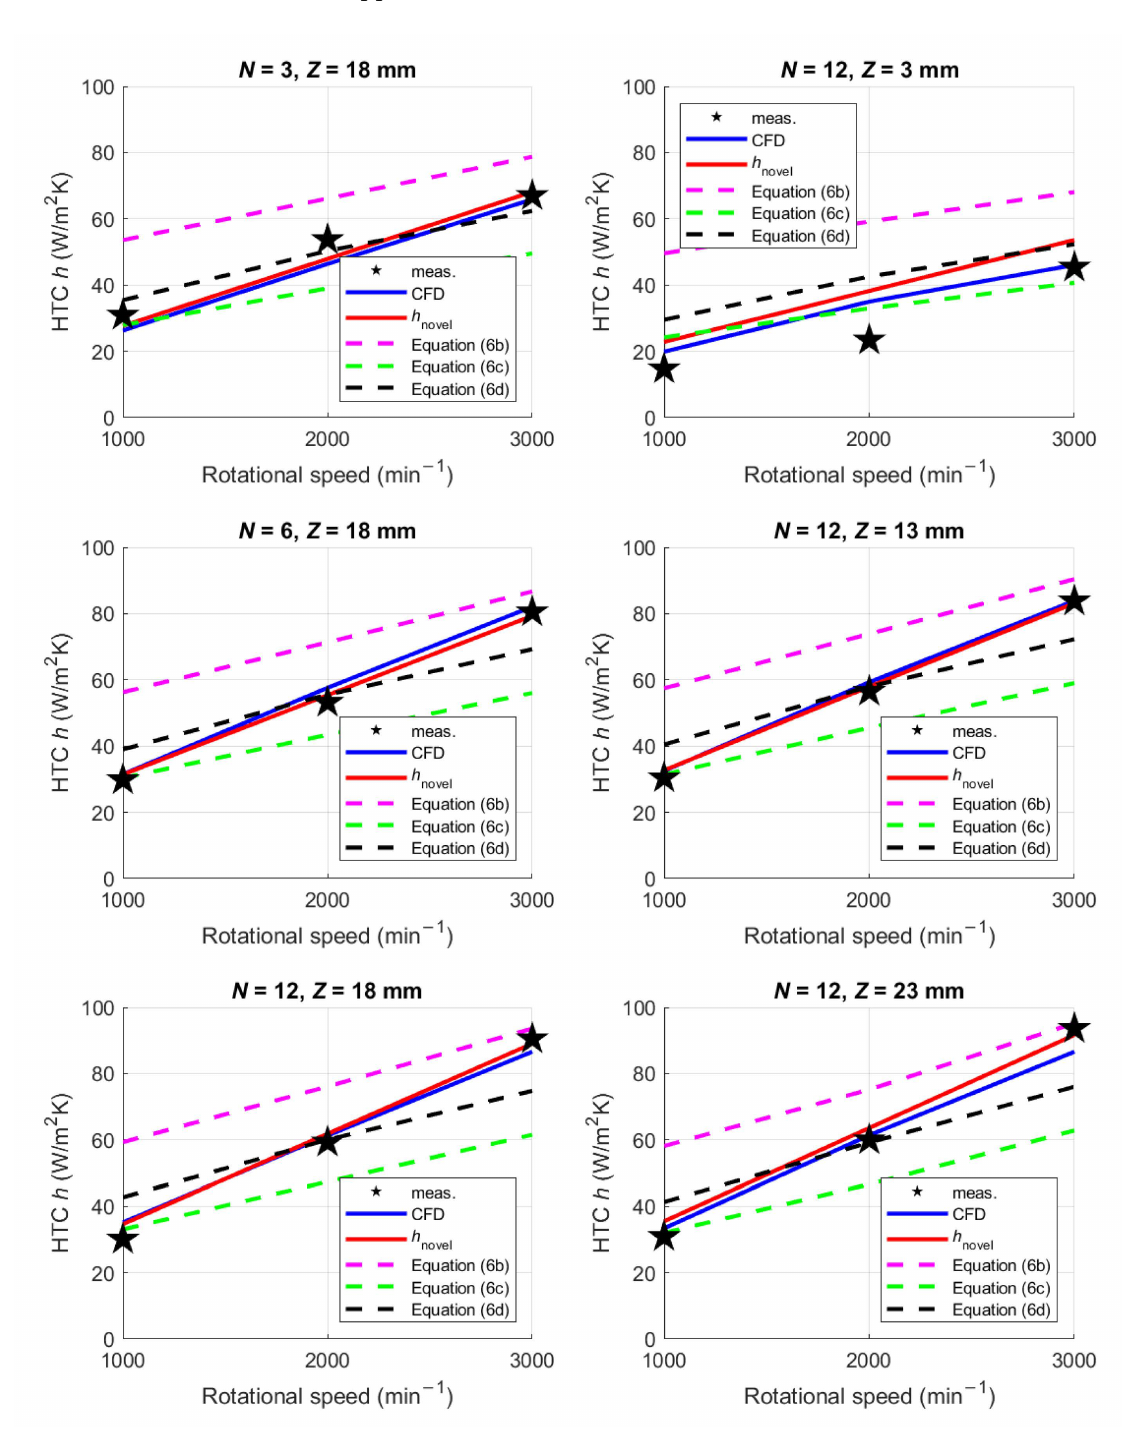
Figure 14. Graphical representation of the difference between the results according to Table